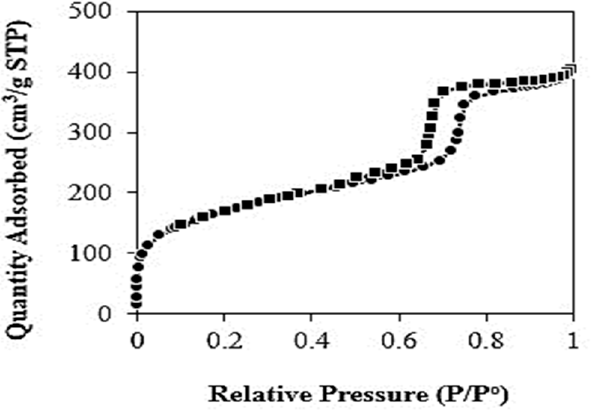
Figure 4. Nitrogen adsorption–desorption isotherm of